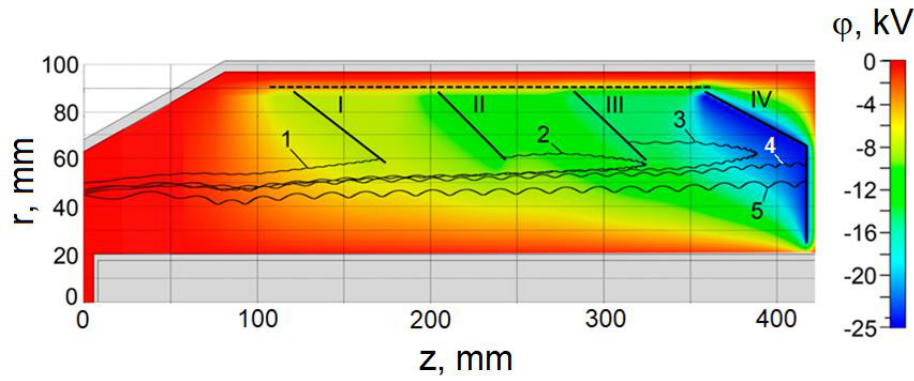
Fig. 4. Electron trajectories 1-5 and distribution of potential φ in r-z cross-section. Elements of the magnetic system are hidden.